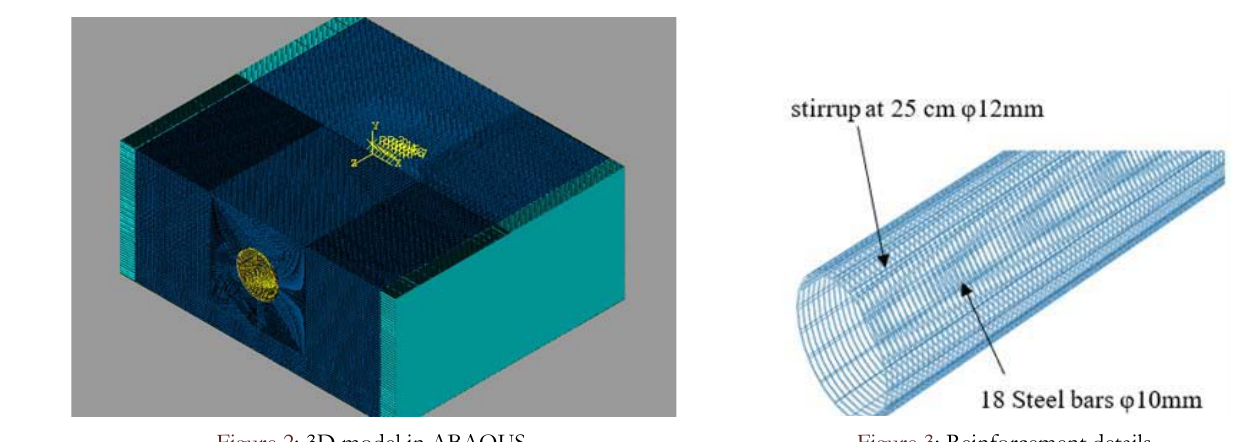
Figure 2: 3D model in ABAQUS. Figure 3: Reinforcement details.